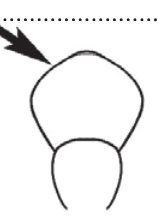
In profile, pronotum of minor worker convex; in dorsal view, pronotum of minor worker with globose outline, that sclerite not or only very weakly